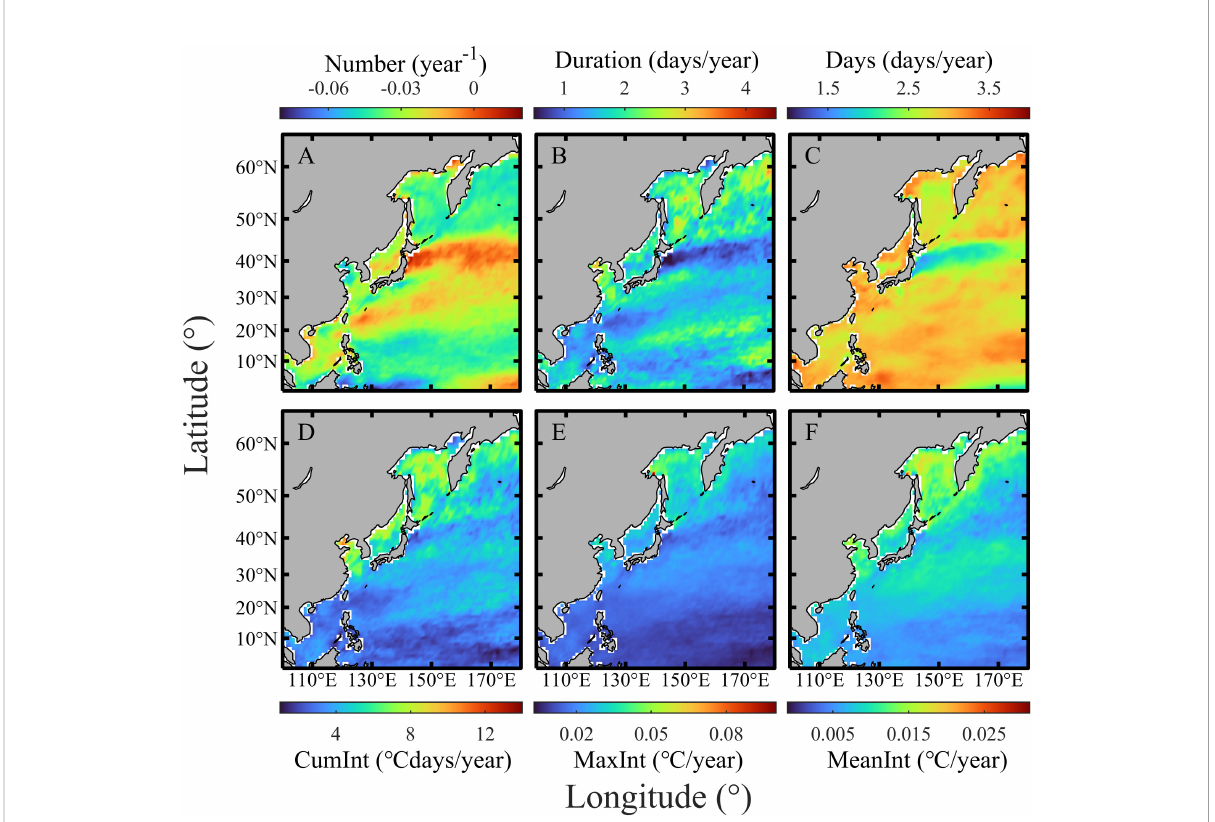
FIGURE 10 Spatial distribution of average annual variation ratio for MHWs characteristics under the SSP2-4.5 scenario. Average of annual variation ratio for MHWs (A) Number (units: year -1 ), (B) Duration (units: day/year), (C) Days (units: day/year), (D) CumInt (units: °Cdays/year), (E) MaxInt (units: °C/ year), and (F) MeanInt (units: